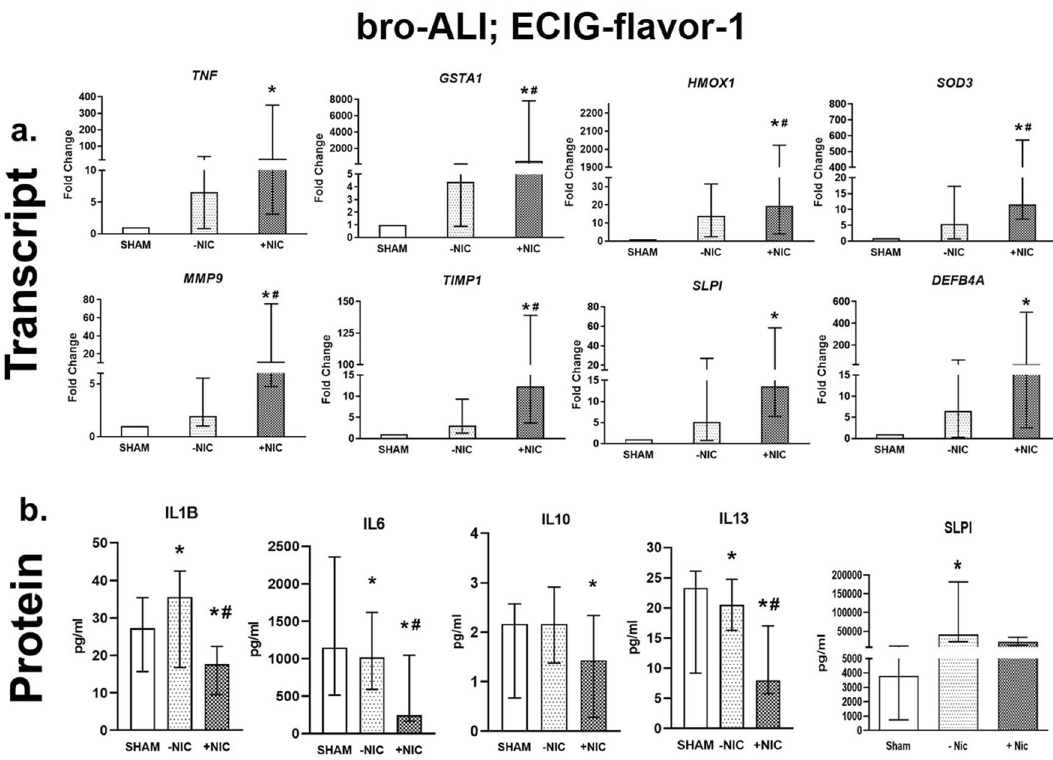
Figure 3. Transcript expression ( a ) and secreted protein levels ( b ) of significantly altered pro-inflammatory, oxidative stress, tissue injury/repair, alarm anti-proteases, and/ or anti-microbial defensin markers in the bronchial mucosa model cultured at air–liquid interface (bro-ALI) following exposure to aerosolized non- nicotinized (−NIC) and nicotinized (+NIC) electronic cigarette liquid flavor 1 (ECIG-flavor-1). Actin beta ( ACTB ) was used as the reference gene. Fold changes for transcript expression were calculated relative to the corresponding sham. *: significantly different from sham; #: significantly different from −NIC ( p < 0.05, Friedman followed by Wilcoxon test). bro-ALI: bronchial mucosa model developed at air–liquid interface DEFB4A : defensin beta 4A, GSTA1 : glutathione S-transferase alpha 1, HMOX1 : heme oxygenase 1, IL: interleukin, MMP9 : matrix metallopeptidase 9, SLPI : secretory leukocyte peptidase inhibitor, SOD3 : superoxide dismutase 3, extracellular, TIMP1 : TIMP metallopeptidase inhibitor 1, TNF : tumor necrosis